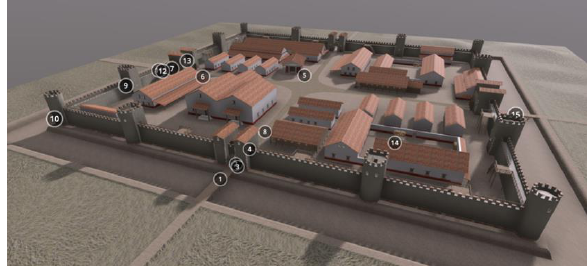
Figure 9: 3D model of the Calstellum on Sketchfab platform (Nivola,